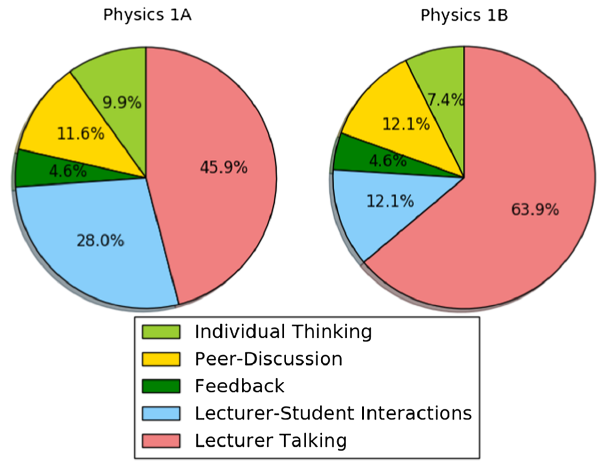
FIG. 2. Types of interaction for 1A and 1B.